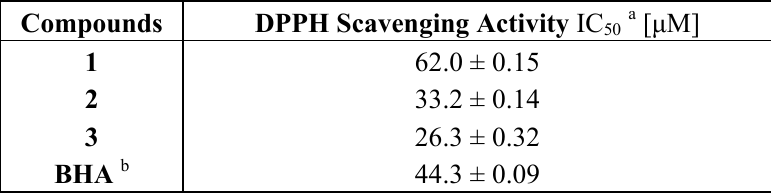
(µM) values of compounds 1 – 3 in antioxidant assay. Table 1. IC 50